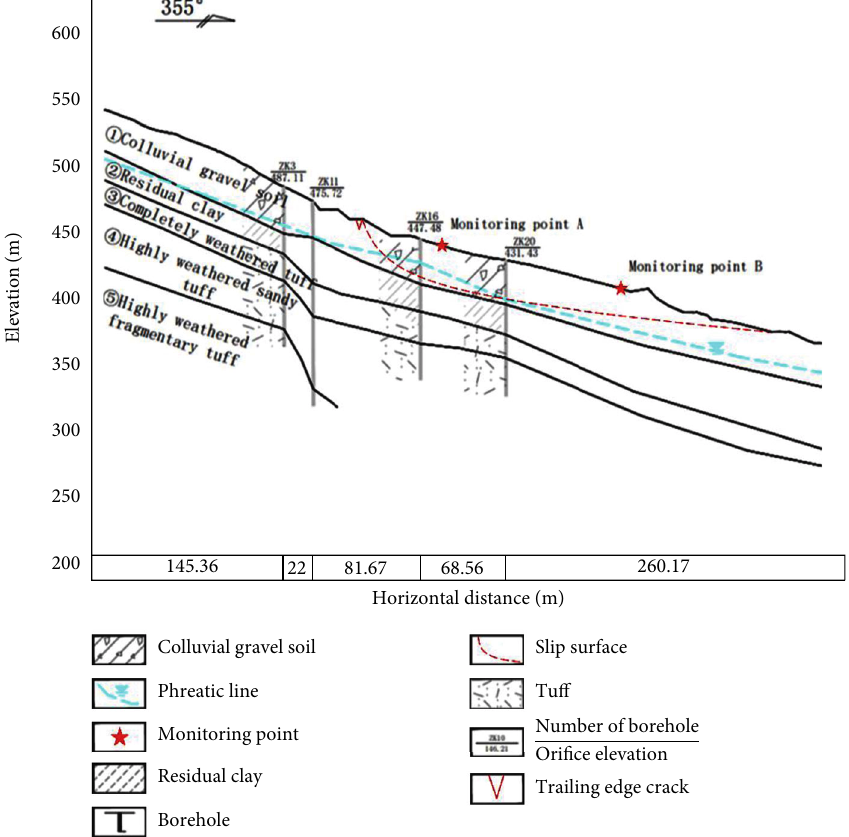
Figure 3: Geological section of the main landslide slip